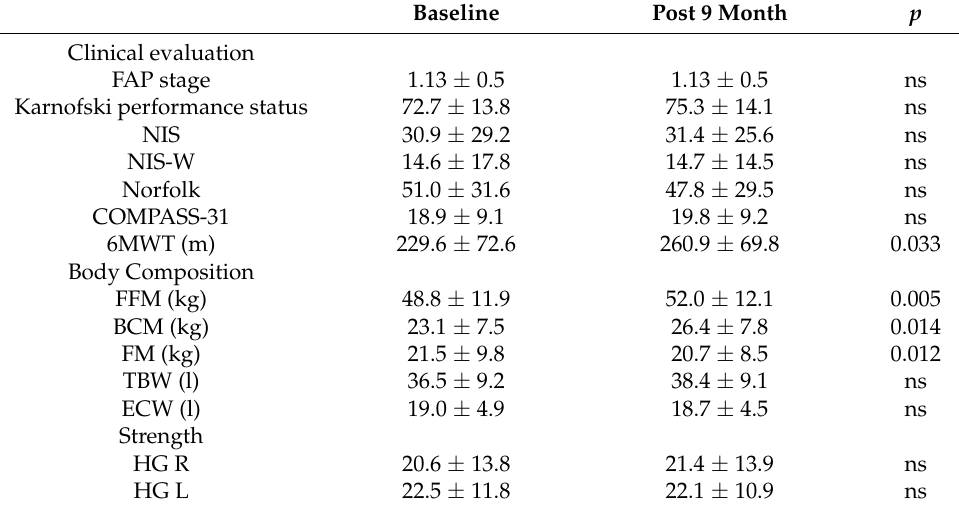
Table 2. Body composition, strength, and 6-min walking test outcomes. Baseline Post 9 Month p Clinical evaluation FAP stage 1.13 ±